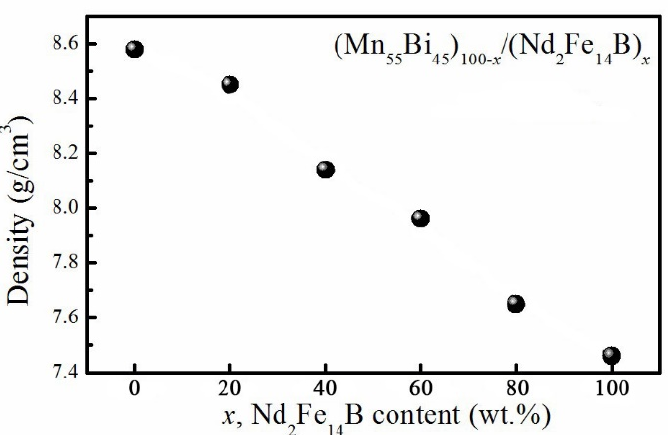
Figure 2. The densities of the bulk (Mn 55 Bi 45 ) 100 − x /(Nd 2 Fe 14 B) x ( x = 0, 20, 40, 60, 80, and 100) hybrid magnetic alloys. Table 1. The density values of the bulk (Mn 55 Bi 45 ) 100 − x /(Nd 2 Fe 14 B) x hybrid magnetic alloys.